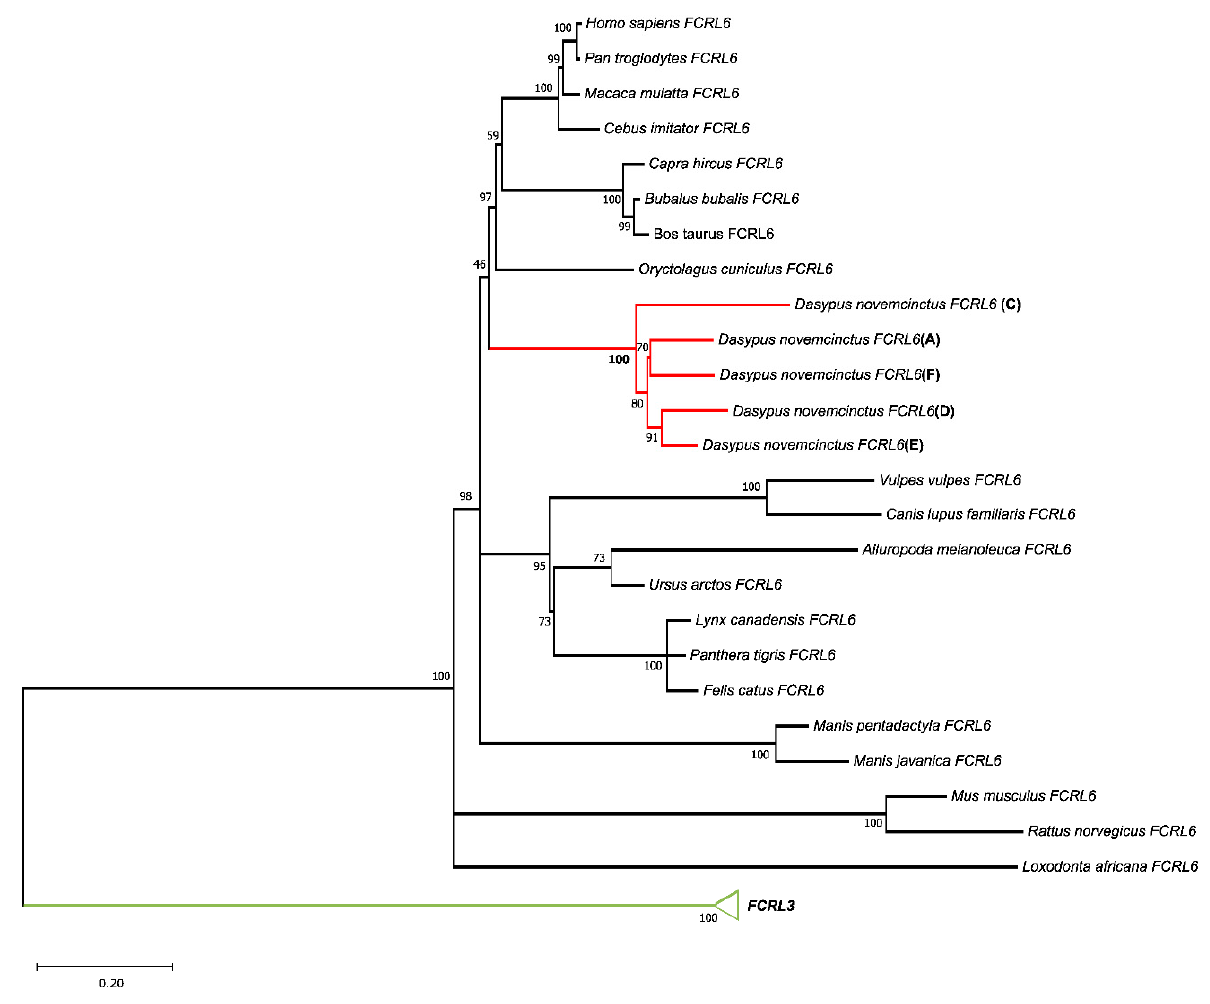
Figure 2. Phylogenetic analysis comparing representative mammalian and D. novemcinctus FCRL6 cDNA sequences. The maximum likelihood (ML) method and the T92 + G + I model of nucleotide substitution were used to assemble the phylogenetic tree. Some groups were collapsed for simplifi- cation. The tree includes FCRL6 genes from D. novemcinctus ( n = 5) (red), FCRL6 genes from other indicated mammals ( n = 20) (black), and was rooted with FCRL3 ( H. sapiens , B. taurus , O. cuniculus , F. catus and M. monocero ) (green). Bootstrap values are indicated to the left of each